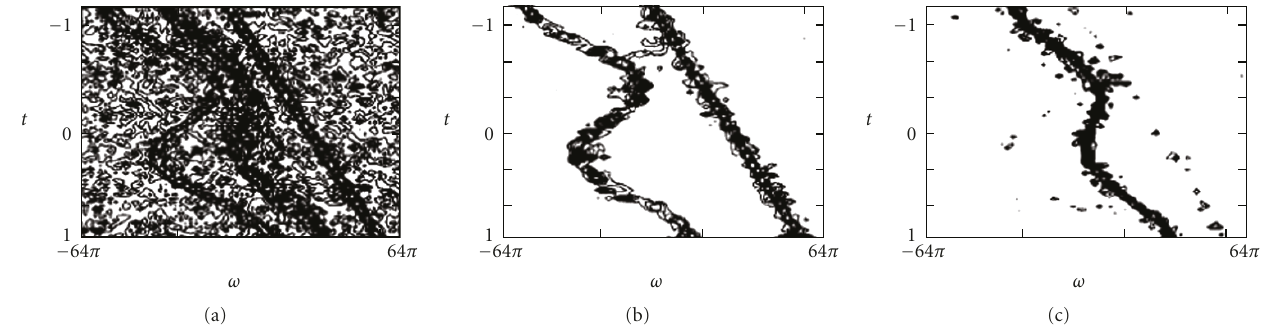
Figure 6: TFD of a signal with fast amplitude variations: (a) the WD, (b) the LWD with L = 2, and (c) the SD distribution with L = 2 (adopted from Stankovi´c